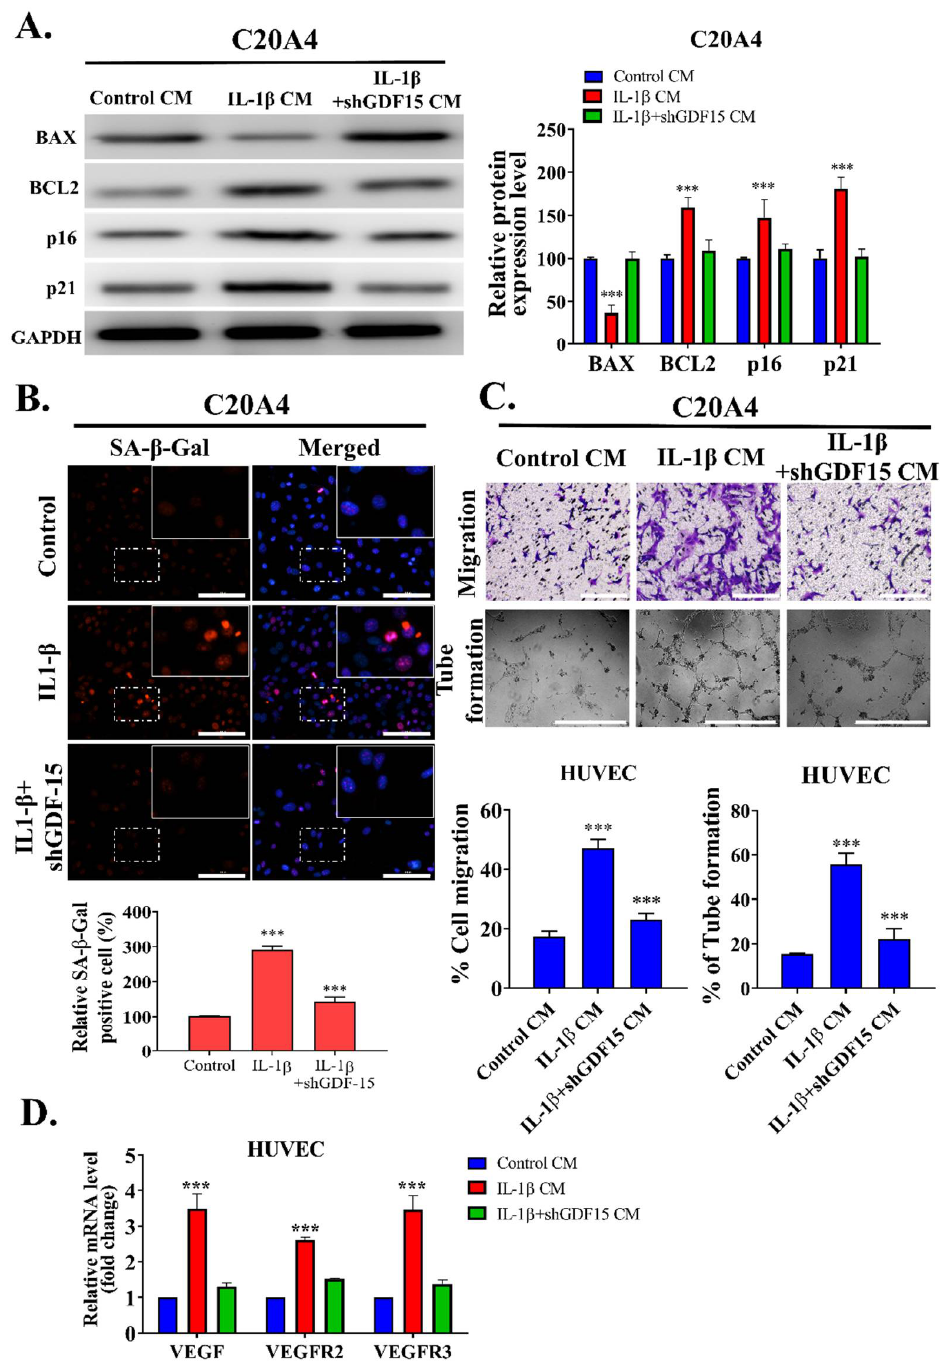
Figure 4. Effect of GDF15 on C20A4 transformation to senescence and SASP and its effect on endothelial cells. ( A ) Western blot protein analysis of BAX, BCL2, p16, p21 in C204 cells treated with conditioned media (Control CM, IL-1 β CM, and IL-1 β + shGDF15 CM). ( B ) Lower level of GDF15 resulted in weaker SA- β -Gal staining in C20A4 cells, implicating their role in chondrocyte senescence. Scale bar: 10 µ m ( C ) Migration (upper panel) and tube formation (lower panel) of HUVEC cells treated with C204 conditioned media (Control CM, IL-1 β CM, and IL-1 β + shGDF15 CM). Scale bar: 100 µ m ( D ) qRT-PCR of angiogenesis markers of HUVEC cell line incubated with conditioned media (Control CM, IL-1 β CM, and IL-1 β + shGDF15 CM). from the GDF15 paracrine/autocrine circuit experimental model. *** p <